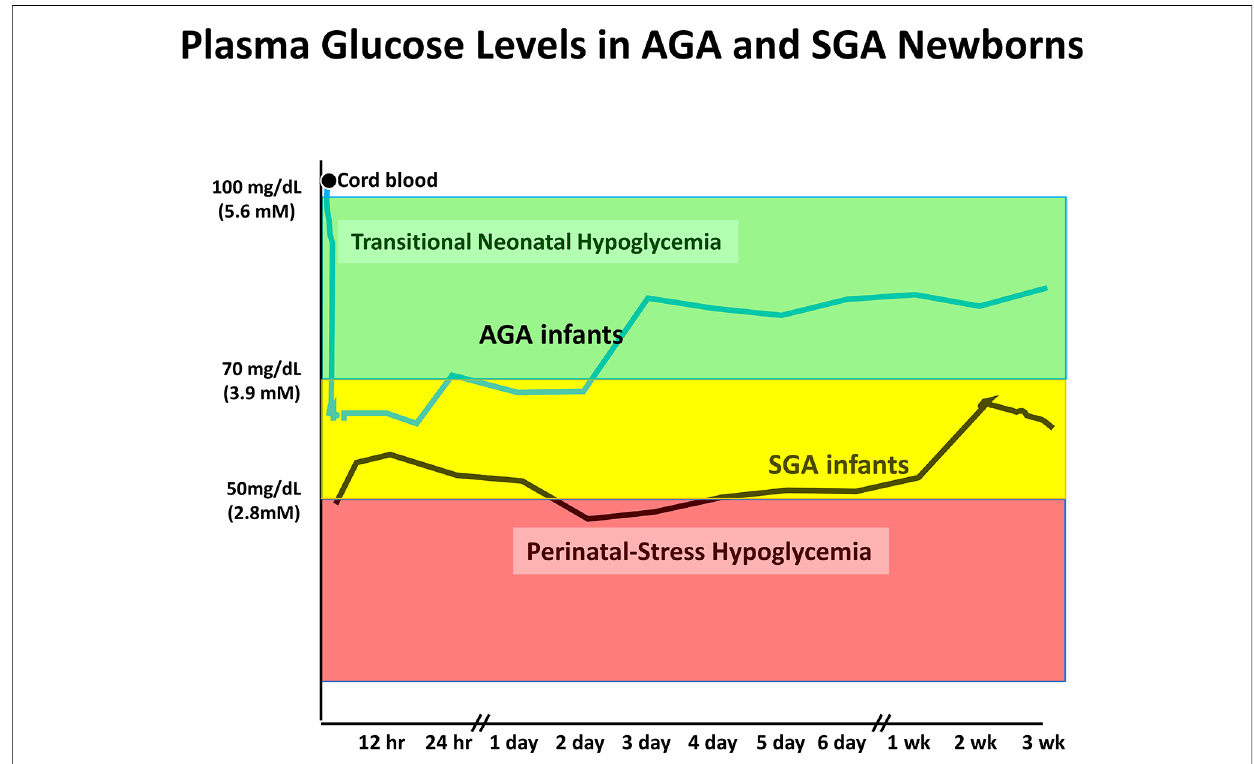
FIGURE 2 Neonatal hypoglycemia in normal AGA newborns and high-risk SGA infants. Mean plasma glucose prior to birth is similar to maternal level and drops to range of 55 – 70 mg/dl during fi rst 12 – 18 h before rising into normal extra-uterine glucose range between 24 and 48 h. Mean glucose drops lower in high- risk neonates (SGA) and remains below normal range for several days up to a few weeks. Similar prolonged neonatal hypoglycemia occurs in other high- risk neonates due to birth asphyxia, maternal hypertension/toxemia, etc. Redrawn from